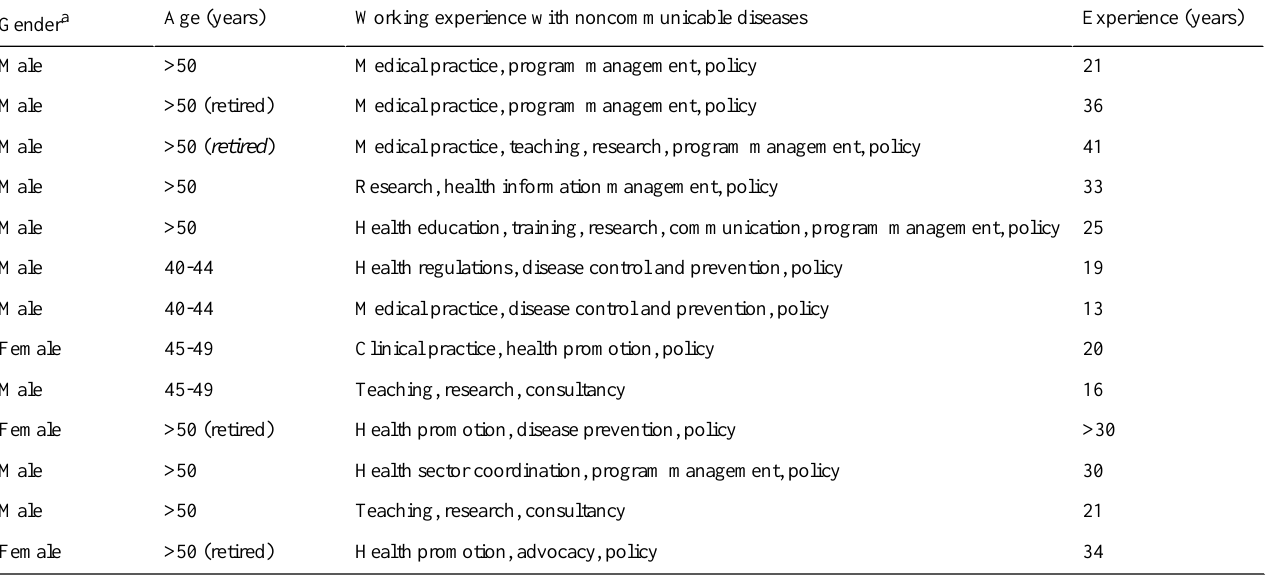
Table 1. Characteristics of the participant health policy makers and managers in Ghana.